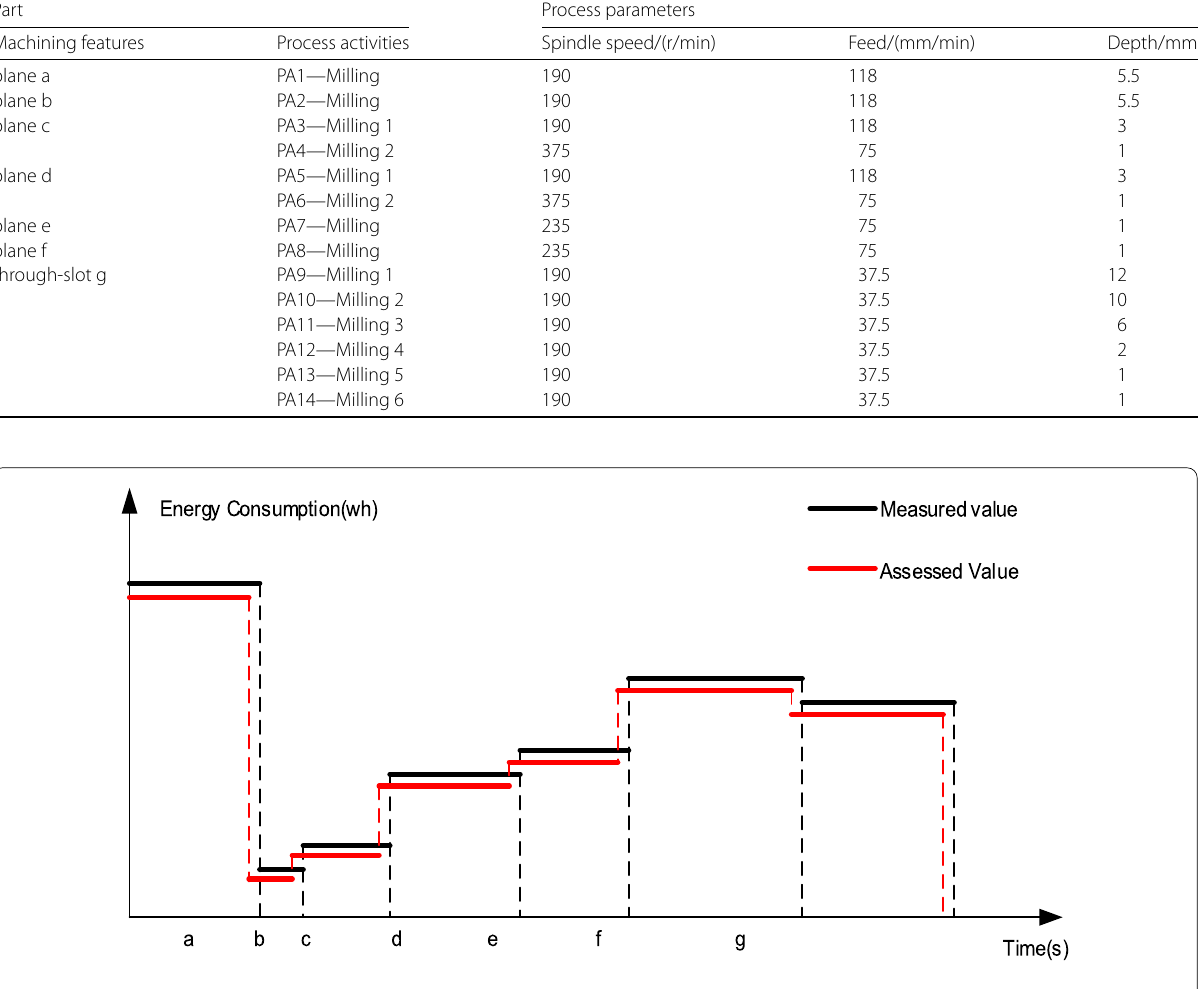
Figure 8 Energy assessment results of